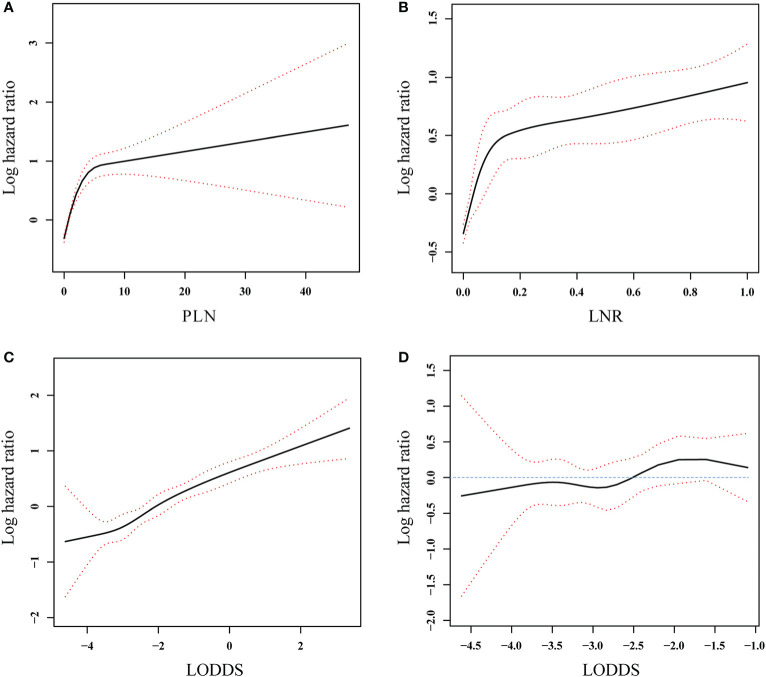
Association between PLN (A), LNR (B), and LODDS (C) and log hazard ratio in all patients and association between LODDS (D) and log hazard ratio in the patients without positive lymph nodes involvement. The solid line and the red dashed lines represent the estimated log hazard ratio and the 95% confidence interval, respectively.